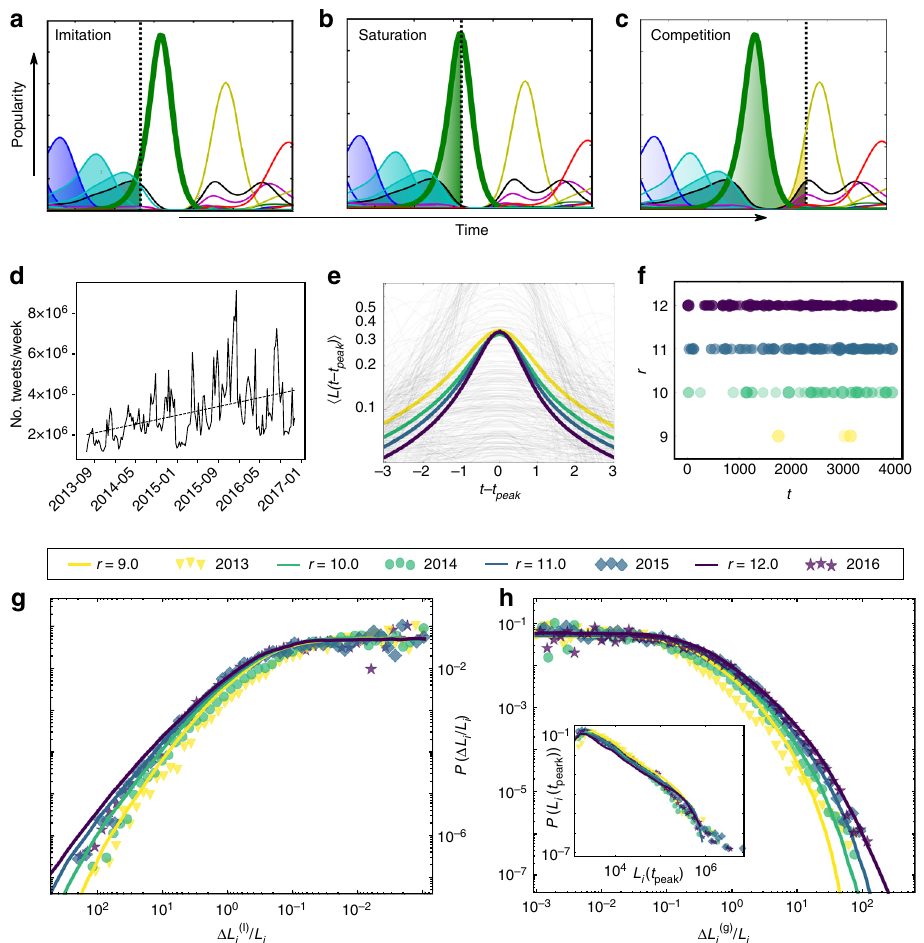
Fig. 3 Modeling attention dynamics: a – c Exemplary details of trajectories resulting from Eq. (1), imitation, saturation and competition. d Total amount of tweets observed per week that contain hashtags among the 50 most commonly used hashtags. Their number grows from two million in late 2013 to four million by the end of 2016. e Average trajectories 〈 L ( t − t peak ) 〉 leading to a local maximum L i ( t peak ) from the numerical solution of Eq. (1) with α = 0.005, c = 2.4 and N = 300 and varying r c = r p = r from 9.0 in yellow to 12.0 in dark blue, as indicated in the legend. f Intensity of bursts and timing. The radii of the circles encode the height of the peaks of extreme events. g Distribution of losses from the simulations (lines), compared with the empirical data from Twitter (symbols) and h distribution of gains (distributions truncated at 10 − 3 ). The inset shows the overlap of the distributions of peak heights P ( L i ( t peak )) (simulated values are rescaled and truncated at 10 3